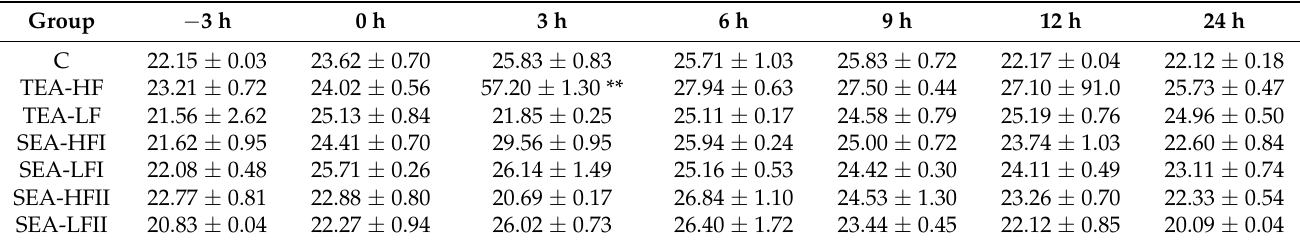
Table 2. Effects of different treatment methods on ALT activity at different time points ( U/L, n = 6 ). Group